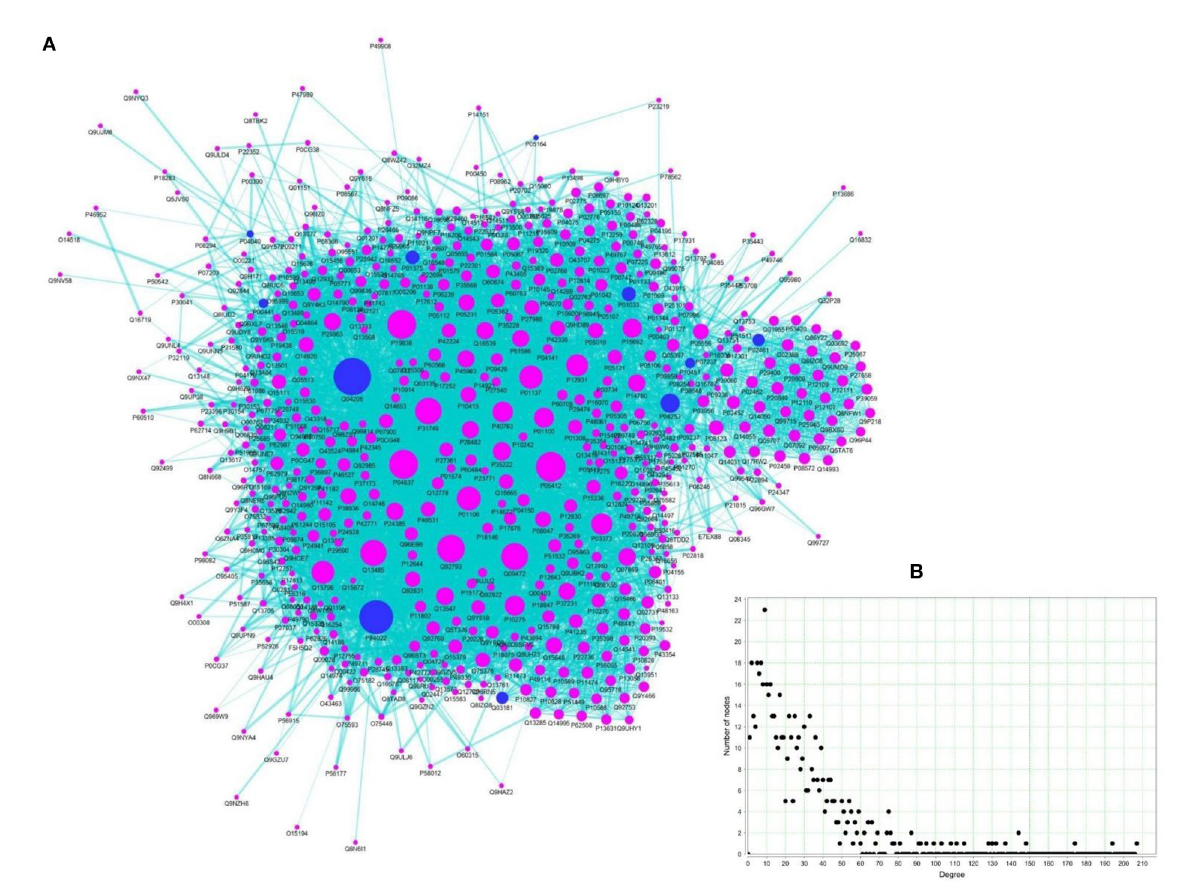
FIGURE7 TC regulated Human Protein Interaction Network (TRH-PIN) of ALD. (A) Protein interaction network of 11 proteins of ALD (blue circular nodes), constructed from STRING with search limited to Homo sapiens and confidence score ≥ 900. The TRH-PIN consists of a network of size 580 nodes and 7,947 edges. (B) Node-degree distribution of